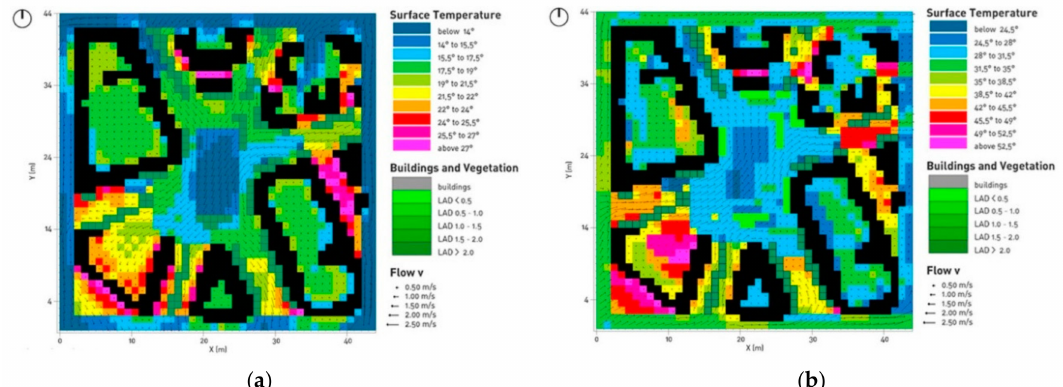
Figure 10. Scenario 2 surface temperature and wind speed analysis: ( a ) Winter analysis based on 21st December at 3:00 p.m.; ( b ) Summer analysis based on 21st June at 3:00 p.m. (analysis software: ENVI-met